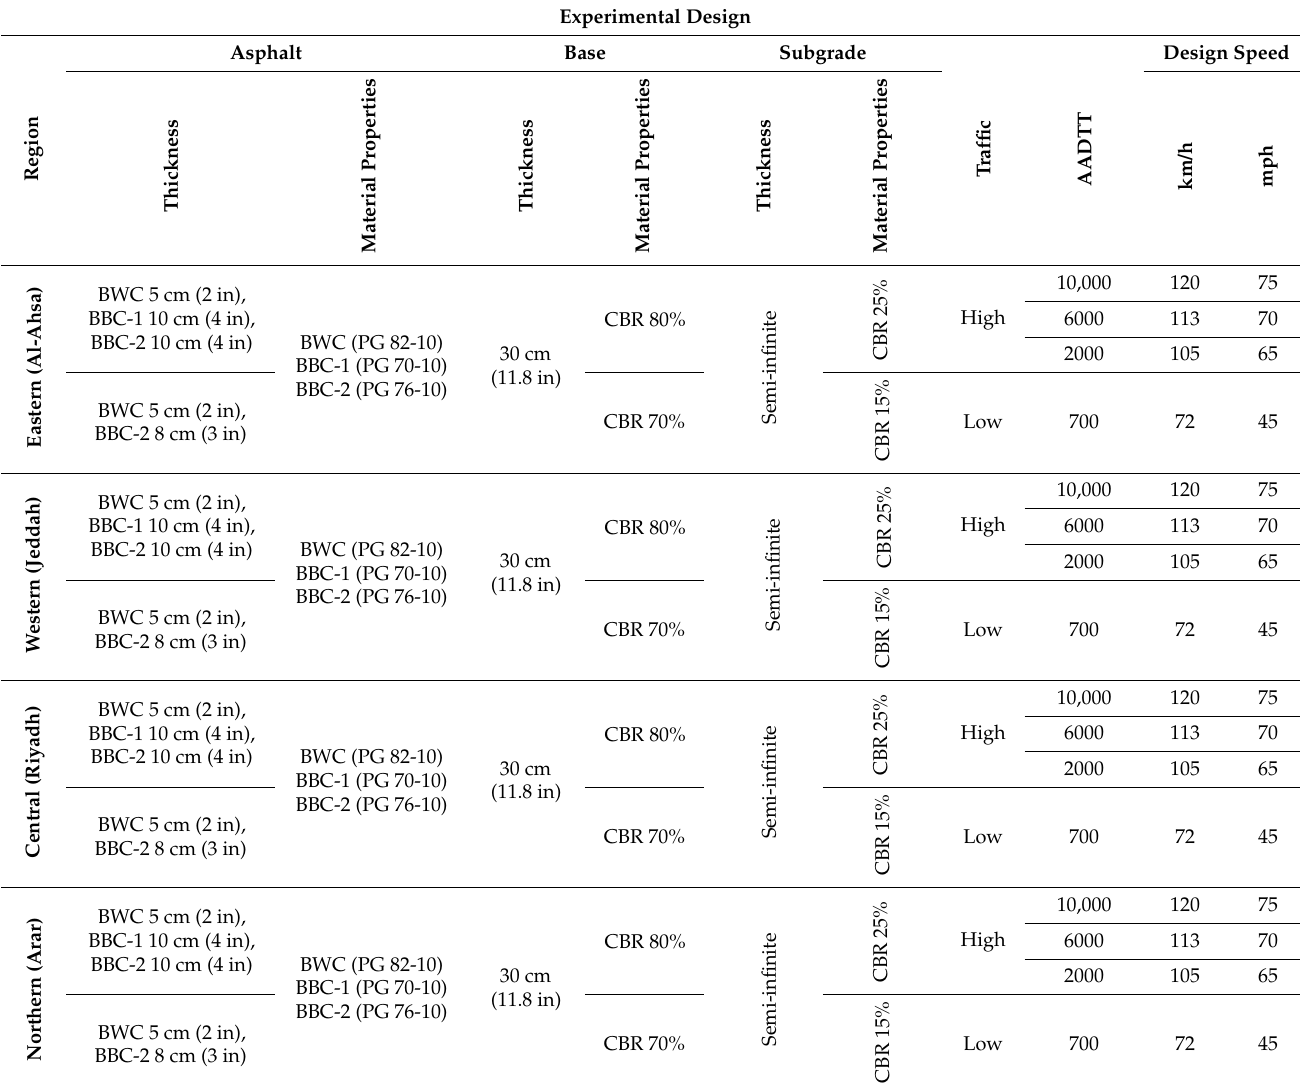
Table 2. Experimental design of the study